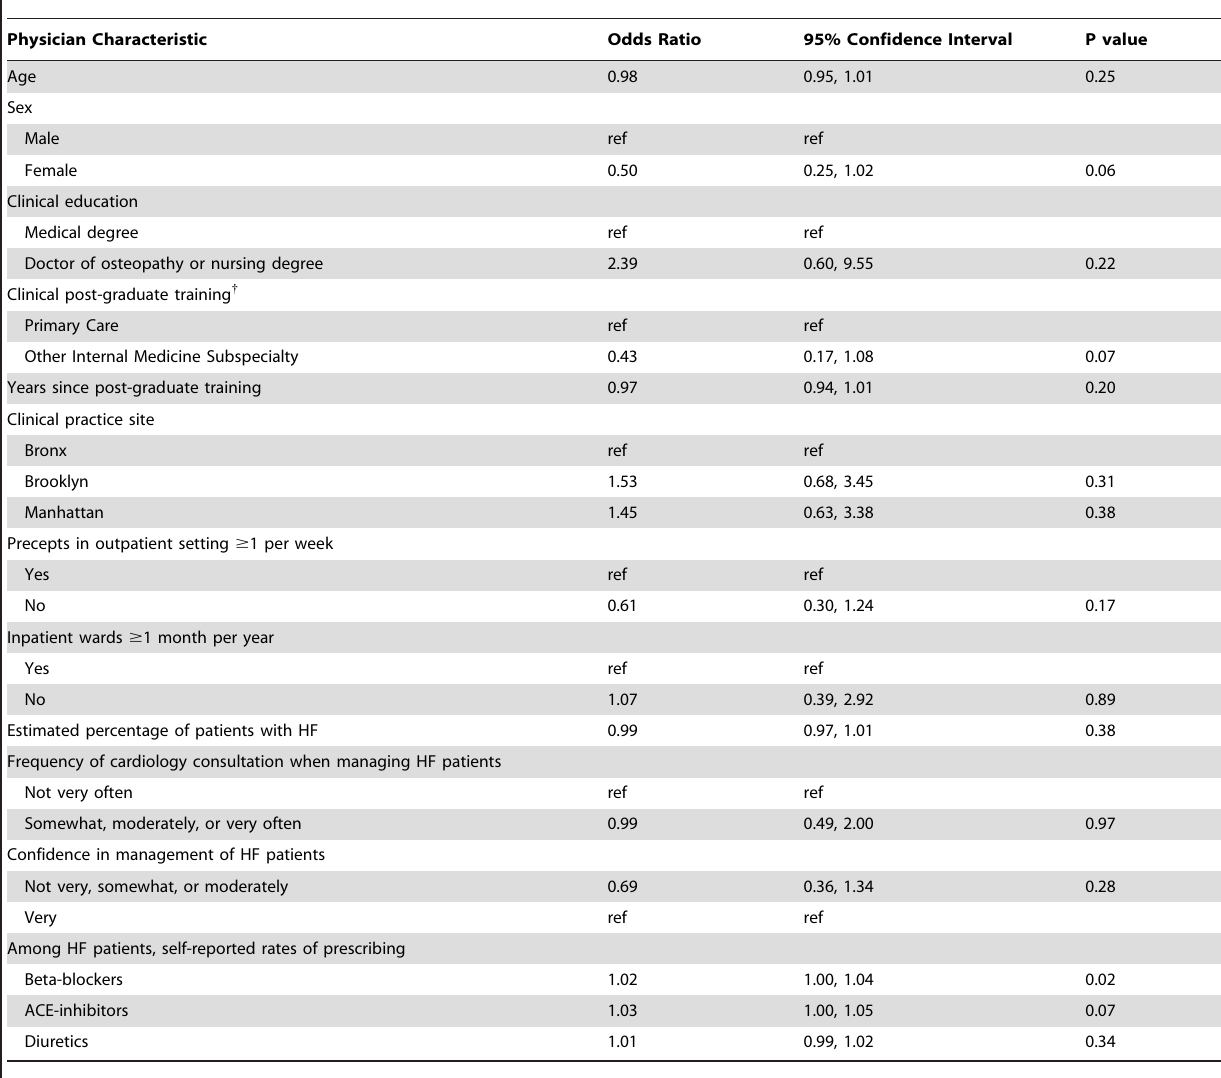
Table 3. Regression estimates from independent Generalized Estimation Equation models examining the association between each physician characteristic and actual prescribing of beta-blockers (mean= 83%) among heart failure patients (n=51 physicians and their 287